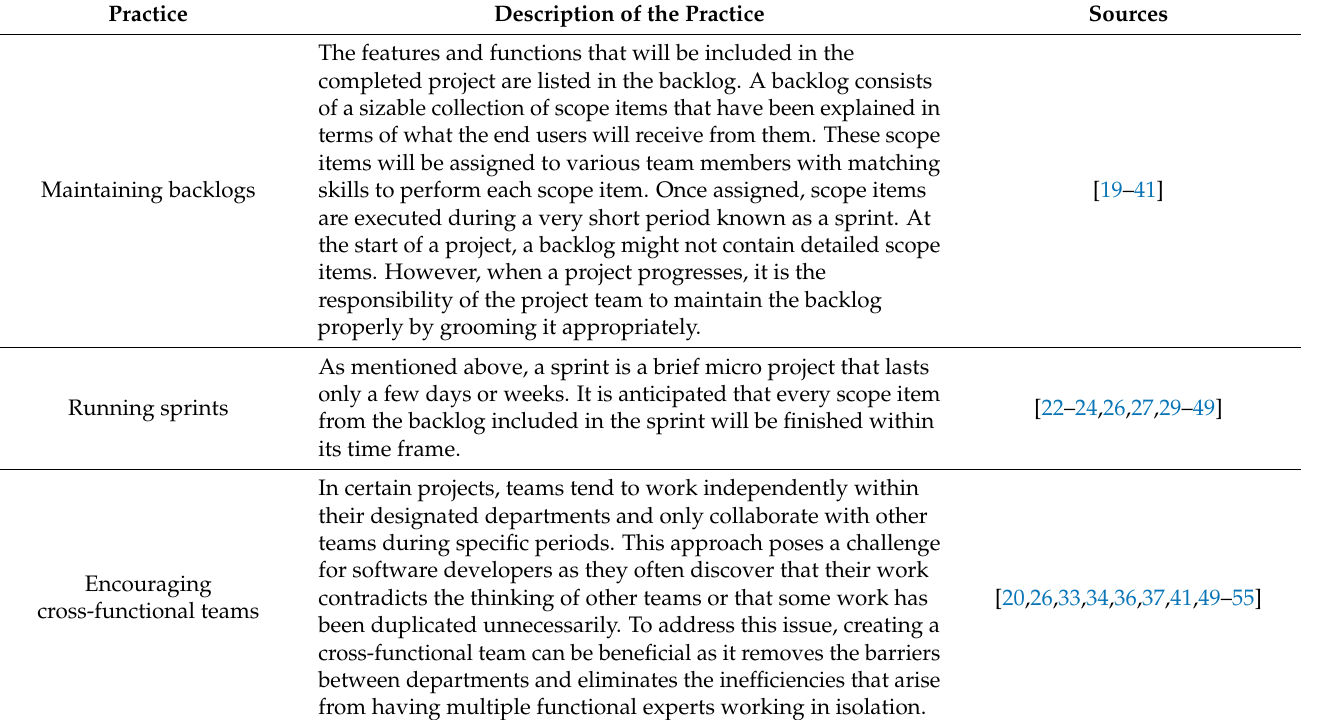
Table 2. Agile practices that could be adopted by building construction firms. Practice Description of the Practice Sources